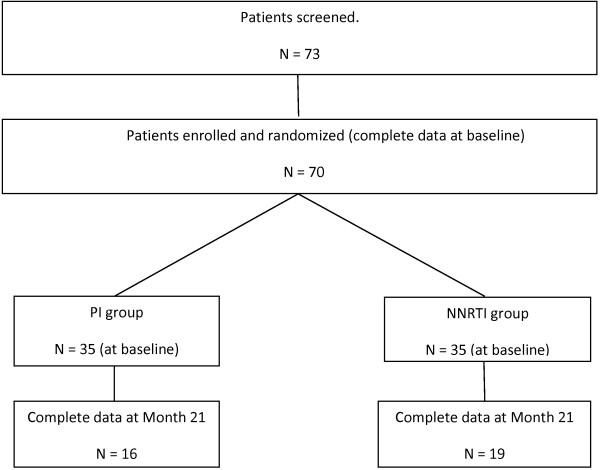
Patients screened, enrolled, randomized, and analyzed in the study.